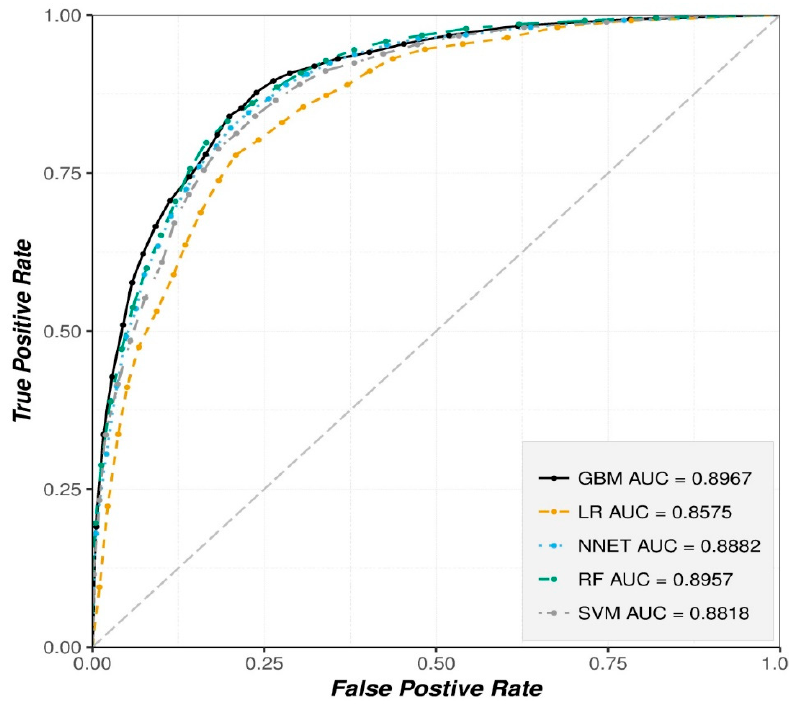
Figure 9. The stacked receiver operating characteristic (ROC) curves of the implemented models.